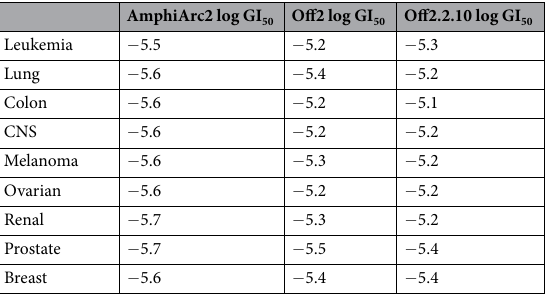
Table 5. Cellular growth inhibition of 60 cell lines in the NCI-60 cancer cell test for the AmphiArc2 (Parent), Off2 and Off2.2.10 peptides. The averaged peptide activity for the cancer types tested is shown as the logarithm of the half growth inhibitory concentration (GI 50 , Supplementary Information Eq. S1), which is the molar concentration of peptide needed to inhibit half of the normal cancer cell growth. The logarithm of GI 50 is shown here as 10 n M. The values from − 5 to − 6 correspond to growth inhibition in the 1–10 µ M range. The growth inhibition values for the individual cell lines are displayed in Supplementary Information Table